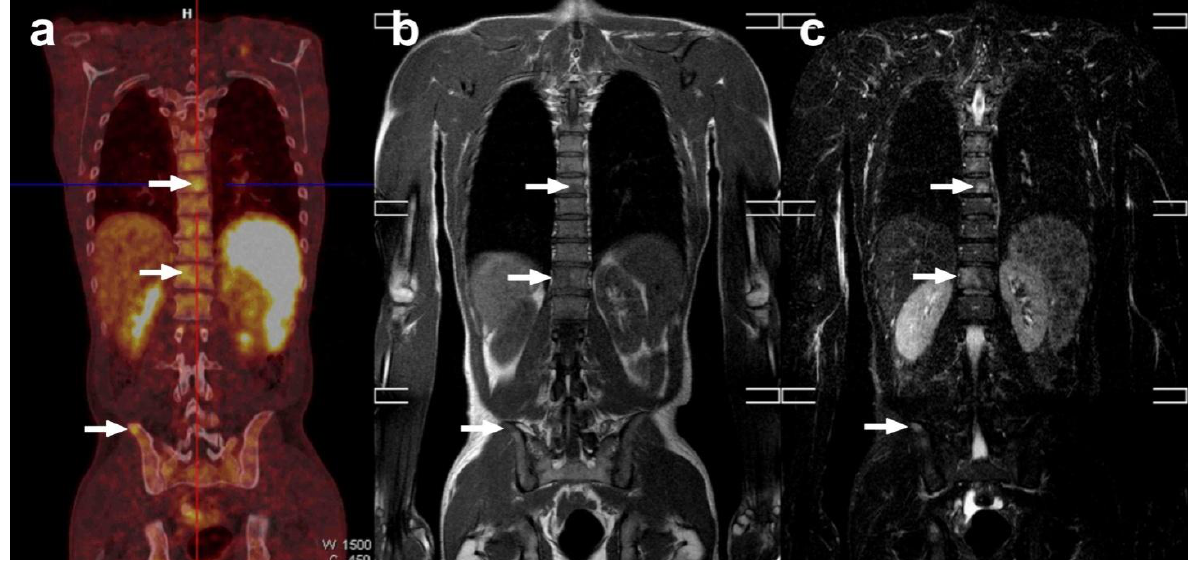
FIGURE 1. Coronal FDG-PET/CT (a), coronal T1-weighted MRI (b), and coronal STIR (short-inversion time- inversion recovery)whole-body MRI (c) in a 45-year-old male with nodular sclerosing Hodgkin lymphoma. Both FDG-PET/CT and MRI show vertebral and iliac bone marrow lesions (arrows). Blind BMB of the right posterior iliac crest confirmed lymphomatous bone marrow involvement. Both imaging modalities also detected extensive supra- and infra-diaphragmatic lymphadenopathy and splenic involvement (not shown).